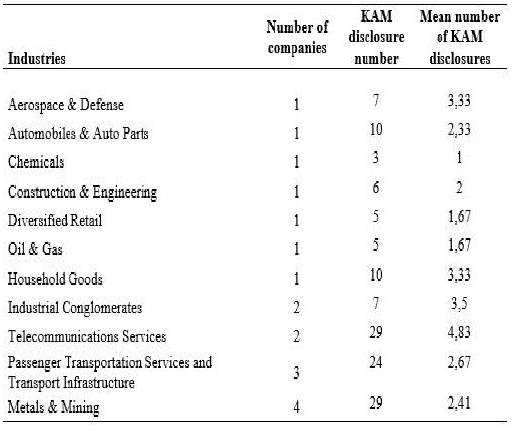
Table 3: Industry Classification of